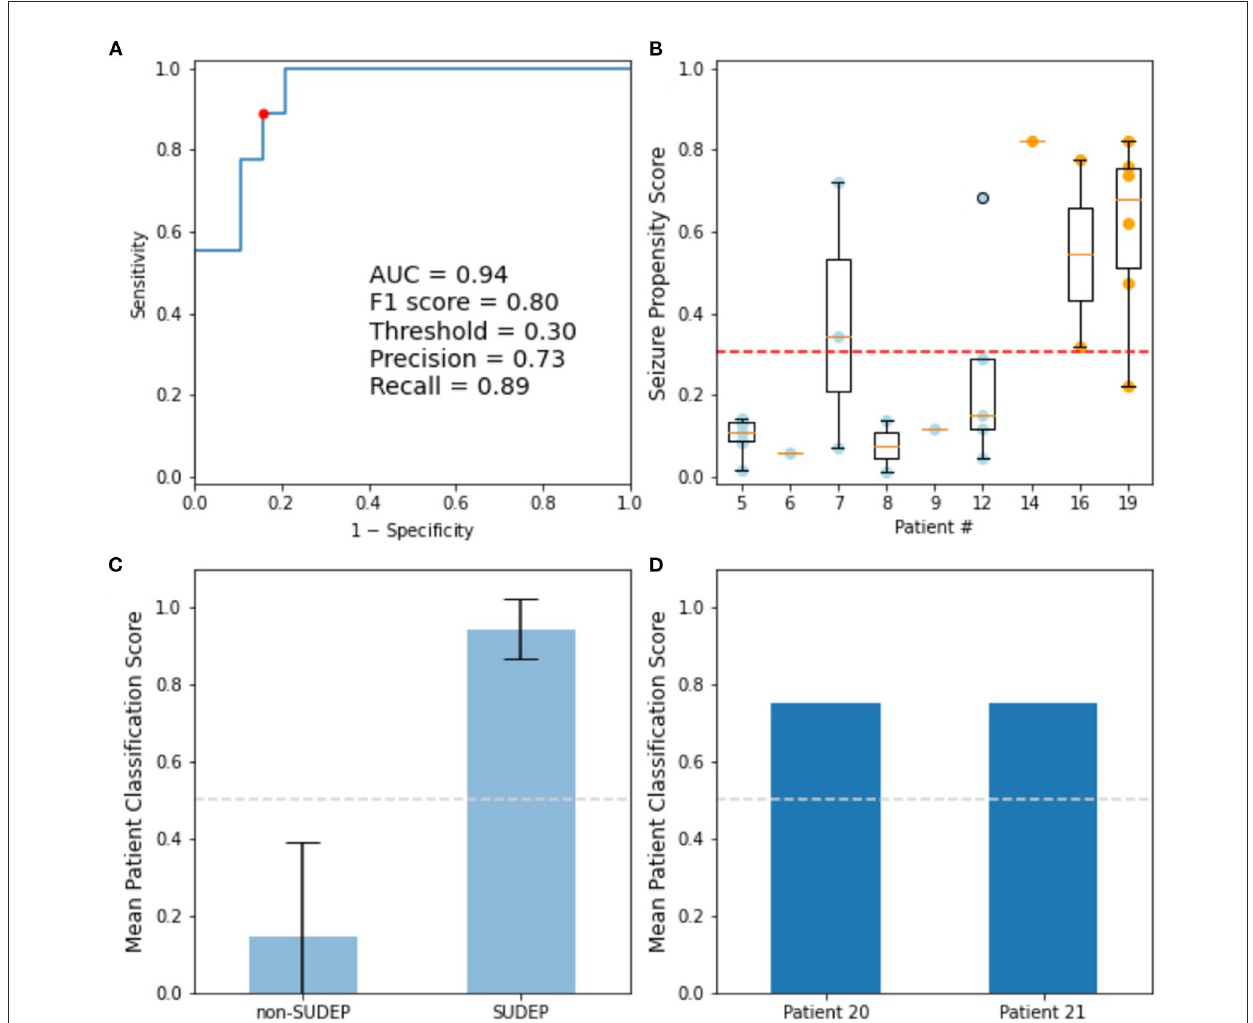
FIGURE5 Logistic classifier trained on alpha determined from PPCs of GTCS. (A) ROC curve of training data: Accuracy optimized point (red), used to determine classifier decision threshold. (B) Training seizure propensity scores by patient; blue dots are non-SUDEP, orange dots are SUDEP patients. (C) Mean training patient classification scores, with standard deviation shown. (D) Mean patient classification scores for GTCS of two eventual SUDEP patients not included in training